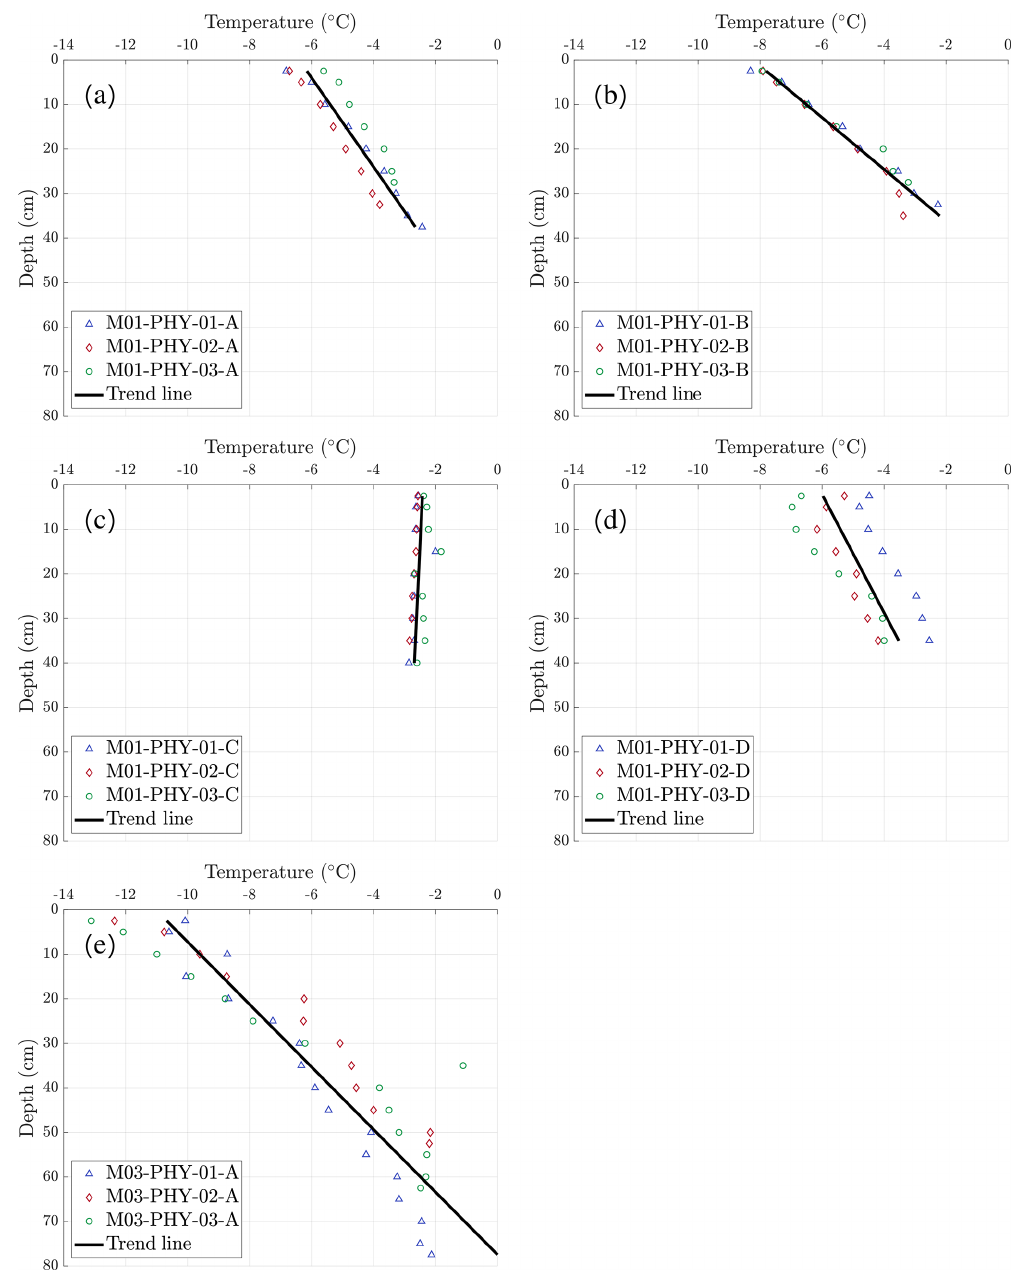
Figure 6. Plots of temperature over sea ice depth for the four pancake ice floes (cores M01-PHY-01-A, M01-PHY-01-B, M01-PHY-01-C, M01-PHY-01-D, M01-PHY-02-A, M01-PHY-02-B, M01-PHY-02-C, M01-PHY-02-D, M01-PHY-03-A, M01-PHY-03-B, M01-PHY-03-C, M01-PHY-03-D) and for the consolidated pack ice (cores M03-PHY-01-A, M03-PHY-02-A and M03-PHY-03-A), respectively.